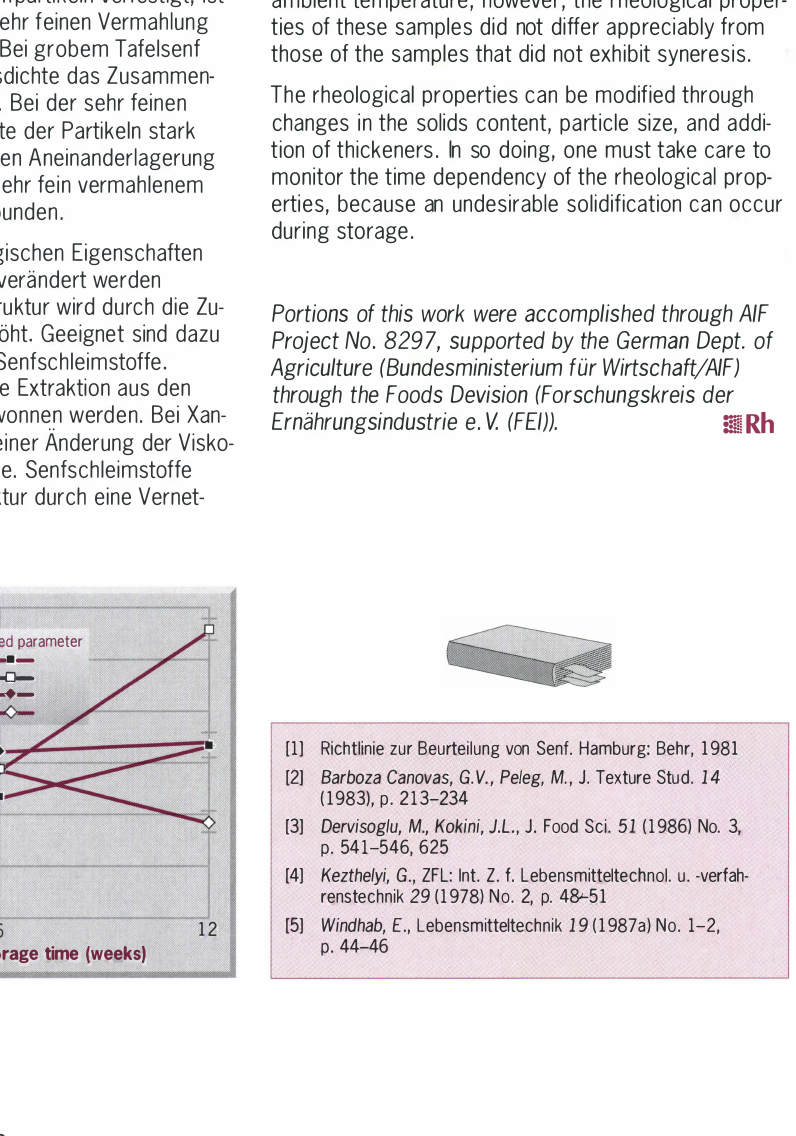
Zusammensetzung auf die gemessene Fliellgrenze SSS: Senfschleimstoffe. Lagertemperatur 25 oc Fig. 8: Influence of the composition on the measured yield stress values. Storage temperature oc = 25